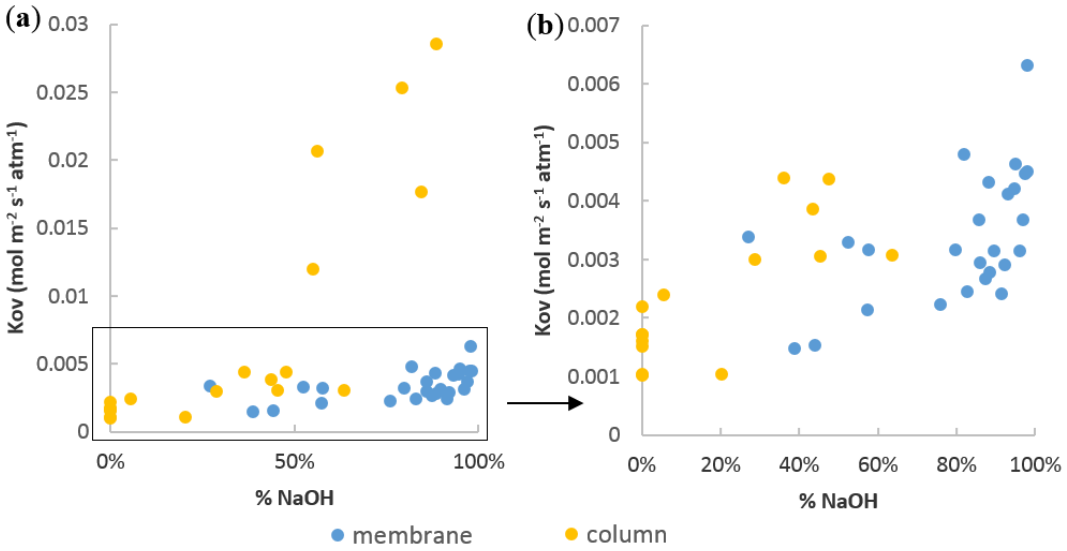
Figure 6. ( a ) Mass transfer coefficient in function of the %NaOH in the liquid solution in the two set ups; ( b ) Zoom of the bottom part of Figure 6a.